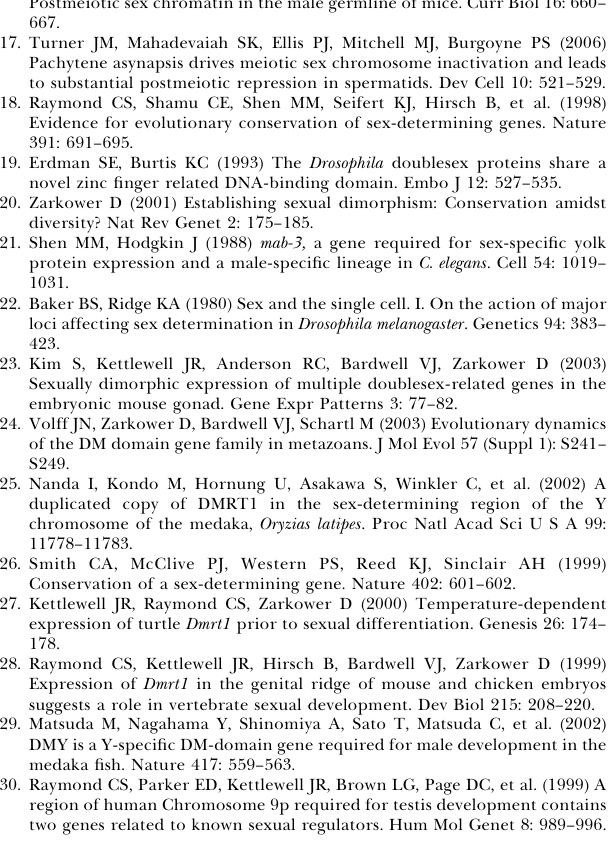
Figure S5. RBMY Silencing in Dmrt7 Mutant Spermatocytes (A) SYCP3 (green) and RBMY (red) immunostaining of spread wild- type and Dmrt7 mutant testicular cells. In wild-type and mutant cells, RBMY is expressed at low levels in leptotene stage. In pachytene spermatocytes, RBMY has fallen to background levels in both wild- type and mutant. (B) SUMO-1 (green) and RBMY (red) immunostaining of adult testis sections from wild-type and Dmrt7 mutant. Pre-meiotic cells near the basal membrane express high level of RBMY whereas SUMO-1- positive pachytene cells do not express RBMY, in both wild-type and mutant, indicating proper silencing. Found at doi:10.1371/journal.pgen.0030062.sg005 (5.4 MB